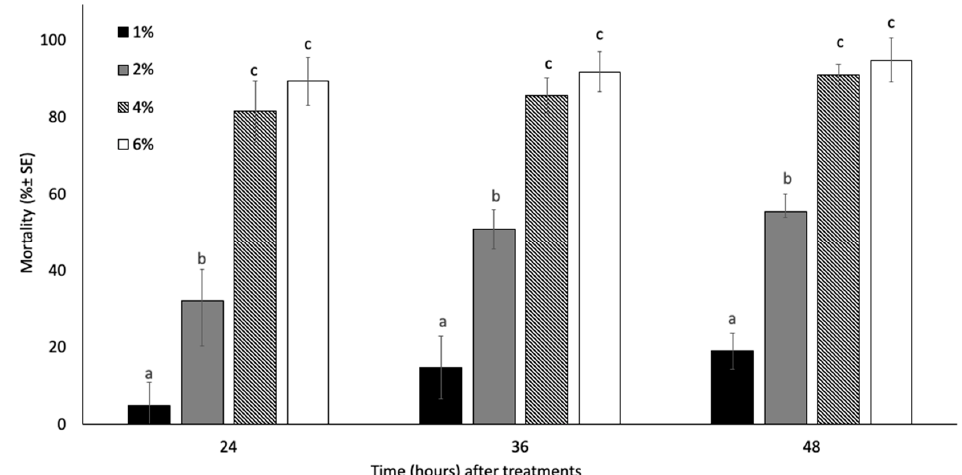
Figure 2. Mean percent mortality ± SE of A. gossypii adults exposed to different concentrations of Citrus sinensis EO nano-emulsion after 24, 36 and 48 h in field trials. Different letters indicate statistical differences among the different treatments at the same exposure time (ANOVA, p < 0.05). The recorded mortality, 24 h after the treatments, ranged from 4.88 ± 6.16 to 89.39 ± 6.34% depending on the EO-NE concentration. In the sampling carried out 36 h after the